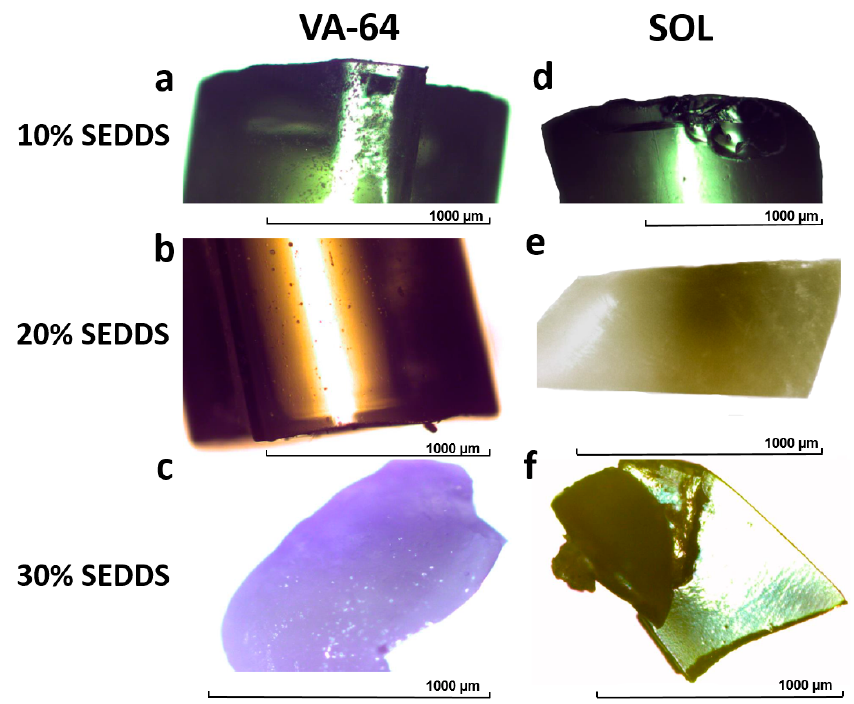
Figure 3. Microscope images of HME–SEDDSs: ( a ) HME–SEDDSs–10%–VA-64, ( b )